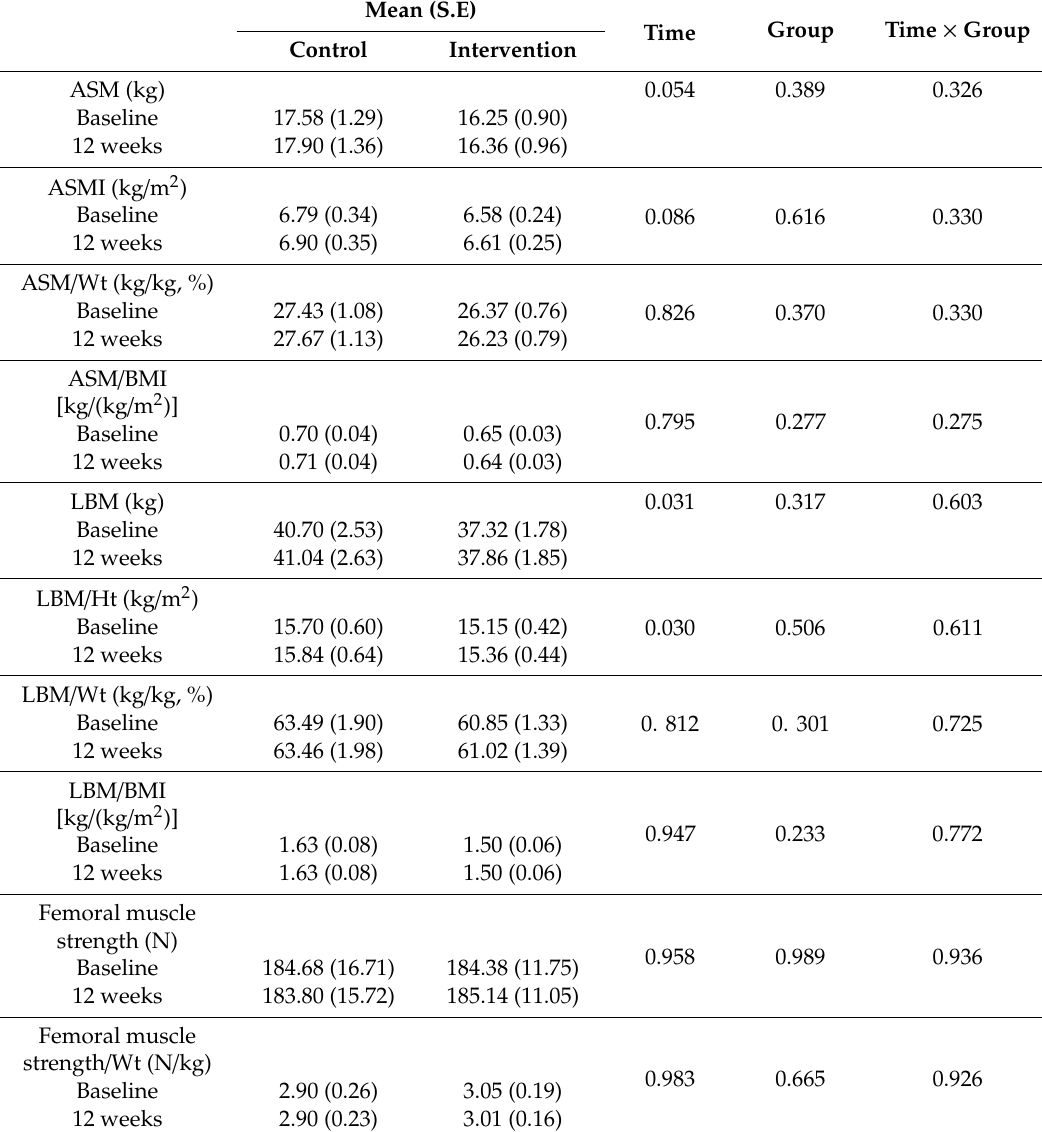
Table 6. Muscle health during the 12-week study period in participants aged 65 years and older (n = 21). Mean